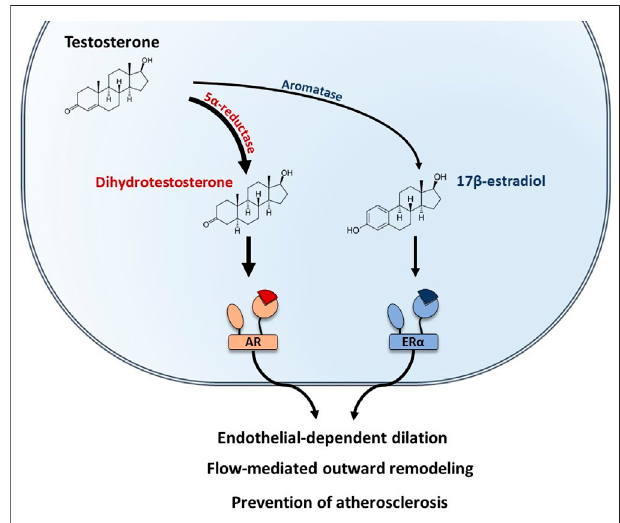
FIGURE 4 | Testosterone-mediated vascular protection is mediated by both AR and ER α in males. In males, testosterone is the predominant sex hormone. Testosteronecan be converted into dihydrotestosterone by the 5 α - reductase and bind to the Androgen Receptor (AR). In addition, testosterone can also be converted into 17 β -estradiol by the aromatase and act on ER α . Both AR and ER α mediate vascular protective effects in males, including endothelial-dependent dilation, protection against atherosclerosis, and fl ow-mediated